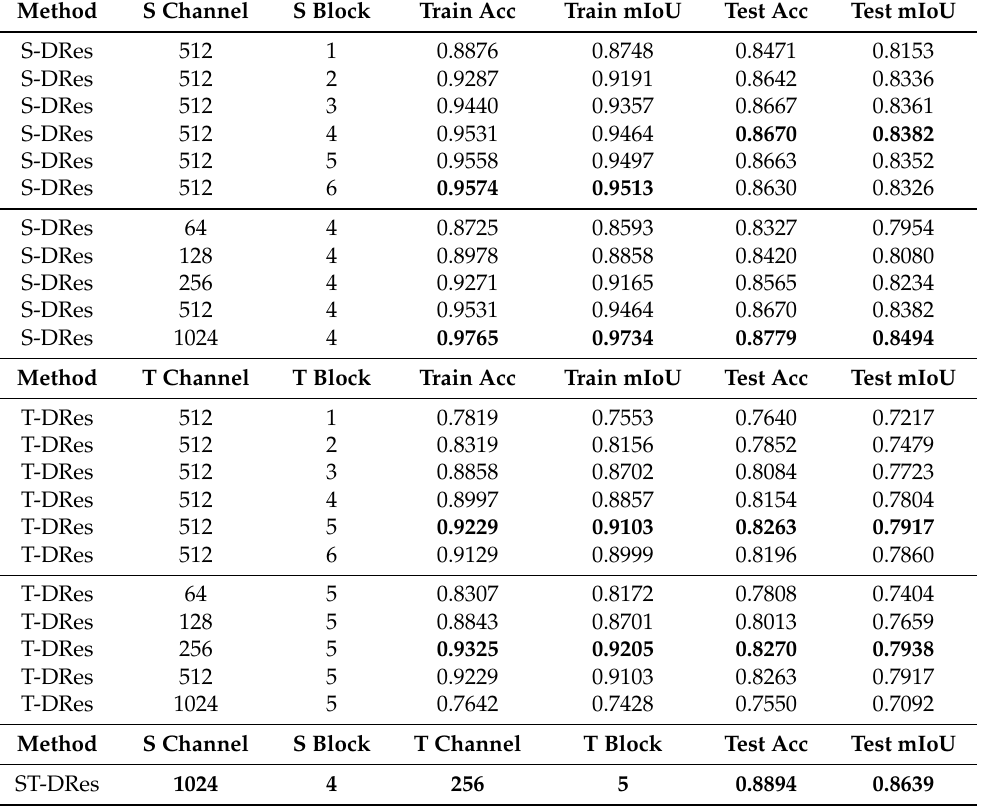
Table 4. Experimental results of the test dataset from the different temporal channels ( N 1 ), the number of temporal blocks ( B 1 ), spatial channel ( N 2 ), and the number of temporal blocks ( B 2 ) from the model architecture (Figure 3). T-DRes indicates that the model uses only temporal blocks. S-DRes indicates that the model uses only spatial blocks. ST-DRes indicates that the model uses both temporal and spatial